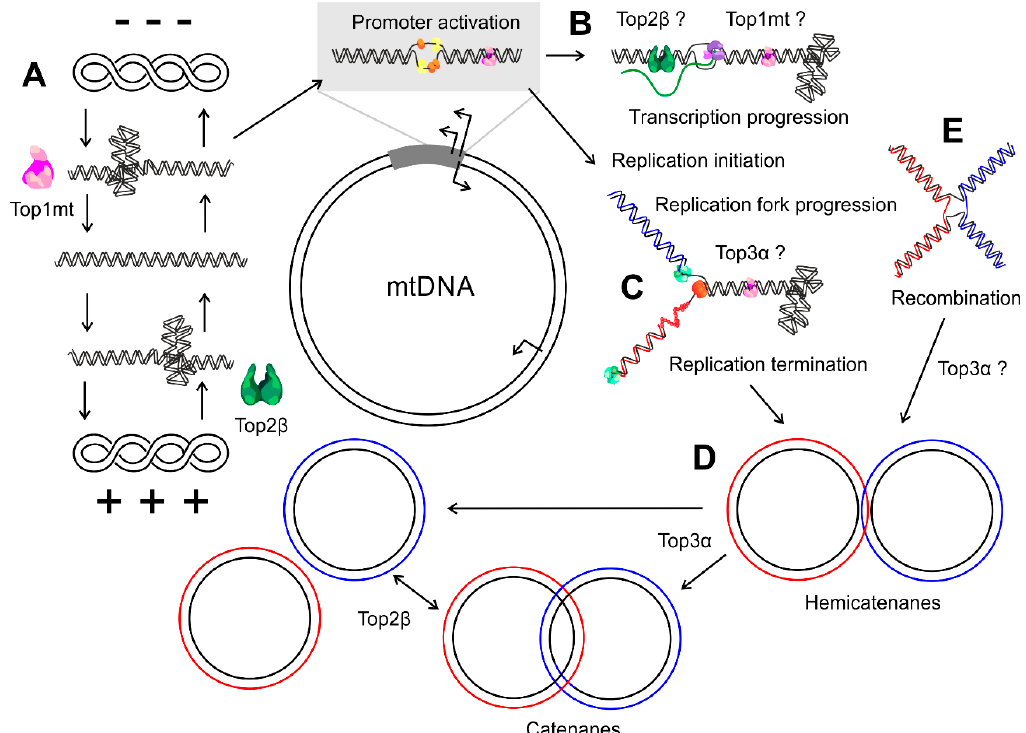
Figure 2. Topological changes in mtDNA metabolism. ( A ) Top1mt and Top2 β together control the topological balance of mitochondrial DNA molecules, thus regulating the initiation of transcription and replication. ( B ) During mtDNA transcription, positive and negative supercoils arise in front of and behind the progressing polymerase complex, respectively, and both Top1mt and Top2 β might be involved in its resolution. ( C ) Which enzymes relieve the positive supercoils accumulating in front of the replication fork and the intertwining of the daughter strands is currently unknown, but first indications speak for a role of Top3 α . ( D ) At the end of replication, the replicated molecules can form hemi- or full catenanes that depend on Top3 α for their resolution and segregation. ( E ) Whether Top3 α or any other topoisomerase participates in the regulation of mtDNA recombination is still unclear. Blue and red colors indicate the nascent leading and lagging strand and, in the case of recombination, the two parental molecules.